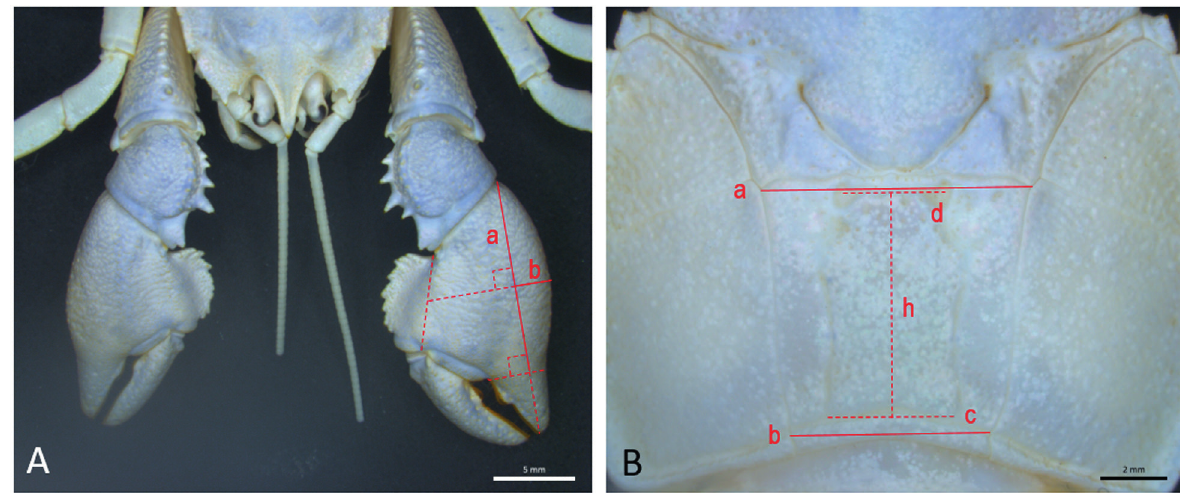
Figure 5. Measurements taken to calculate: A, height of palm of both major and minor chelae (solid lines a, b, as indicated on major chela); B, shapes of cardiac (solid lines a, b) and areolar (dashed lines c, d, h) areas. See “Materials and Methods” for